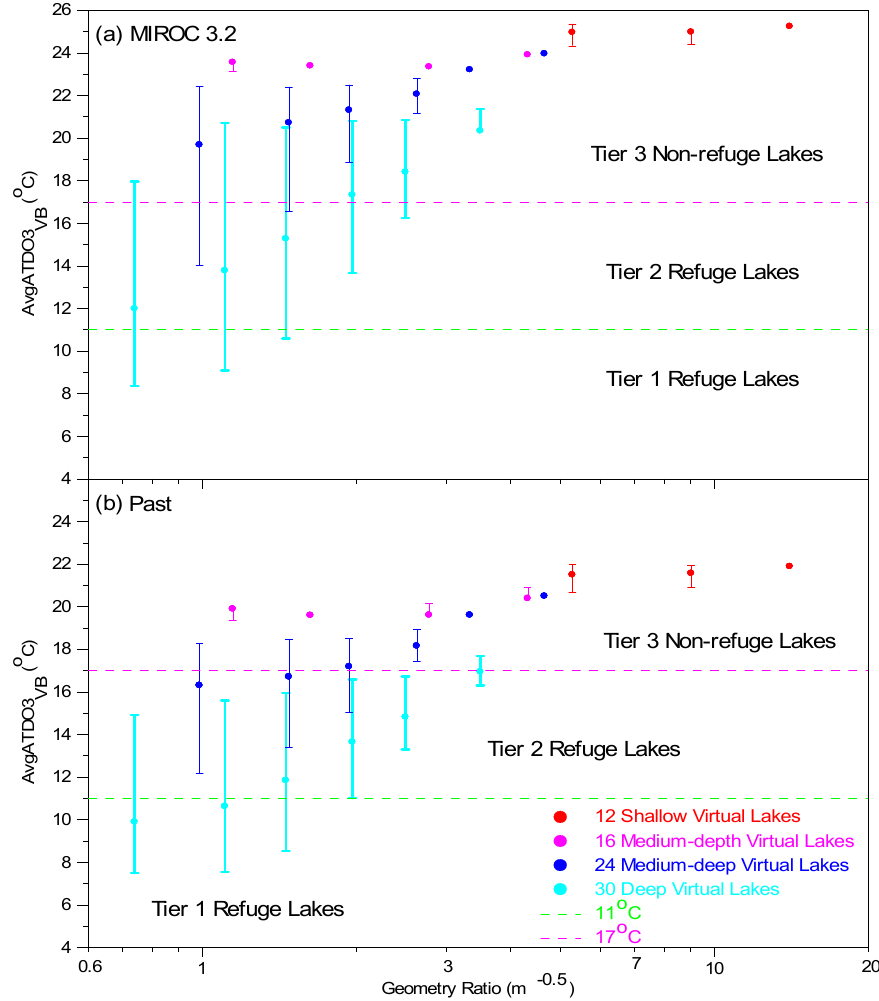
Figure 9. Mean (points), maximum and minimum values of AvgATDO3 VB for different trophic status (Secchi depths) for the four types of mid-latitude virtual lakes (near Duluth) versus lake geometry ratio under ( a ) the MIROC 3.2 future and ( b ) past climate scenarios.